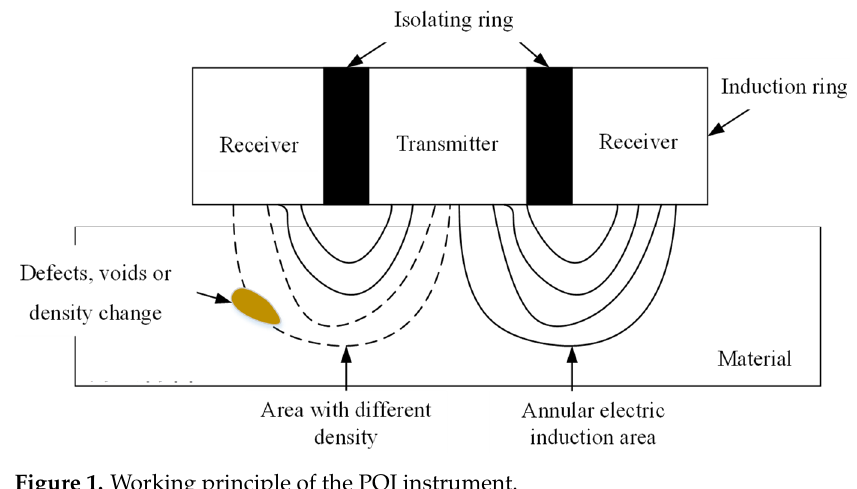
Figure 1. Working principle of the PQI instrument.